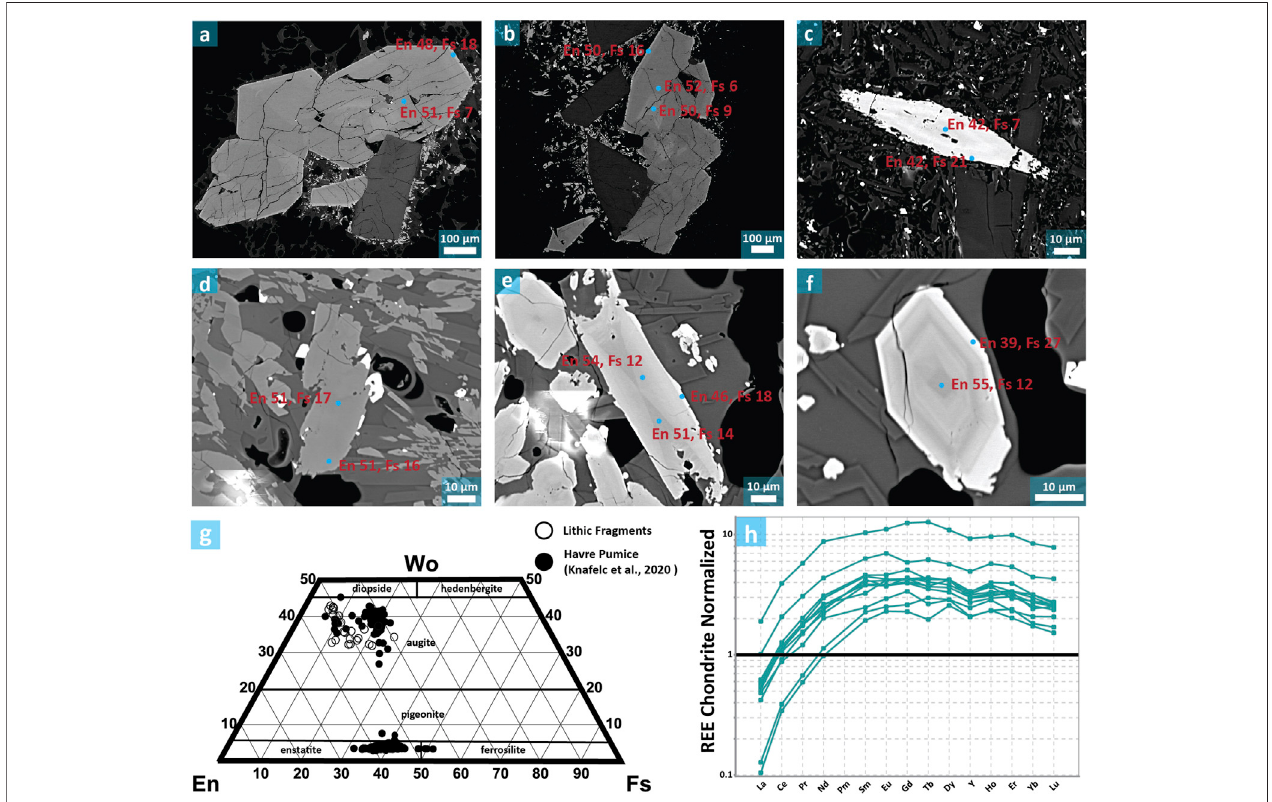
FIGURE 6 | Group 1 embedded rock fragments compared to Havre 2012 pumice. (A – F) Backscattered electron (BSE) images of clinopyroxene within Group 1 embedded rock fragments showing (A , B) larger phenocrysts with subtle normal zoning, (C , D) subhedral clinopyroxene microphenocryst with resorbed rims, (E) clinopyroxene with sector/hourglass zoning, and (F) clinopyroxene with oscillatory zoning. (G) Pyroxene quadrilateral diagram comparing the compositions of Havre rhyolite pumice antecrystic clinopyroxene from Knafelc et al. (2020) to clinopyroxene within Group 1 rock fragments (projection scheme of Lindsley and Andersen (1983). (H) REE contents of clinopyroxenes in rock fragments normalized to chondrite (McDonough et al., 1985).